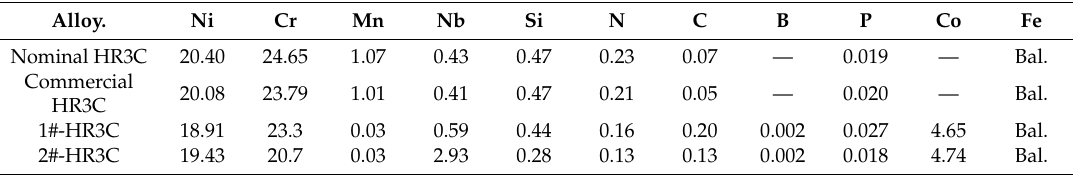
Table 1. Compositions of the three groups of HR3C alloys detected by inductive coupled plasma (ICP)